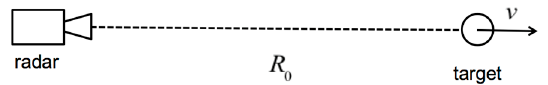
Figure 1. Radar and target moving at speed v away from the radar.